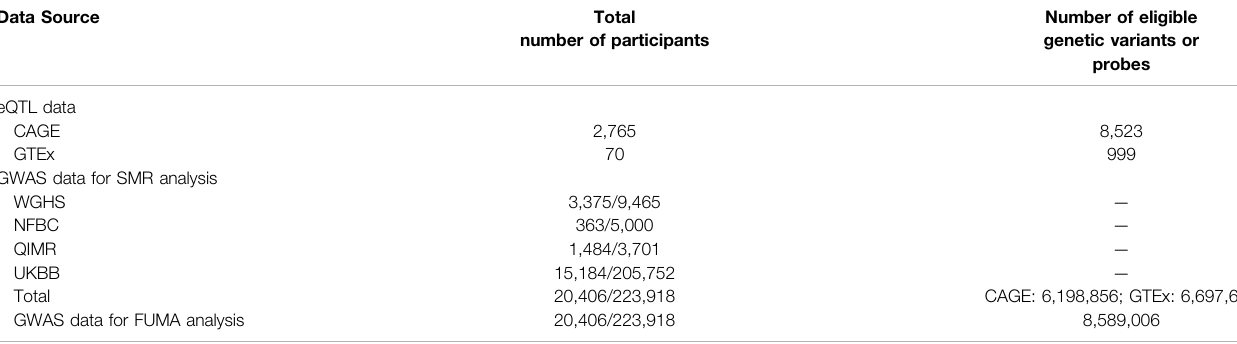
TABLE 1 | Basic information of the eQTL and GWAS